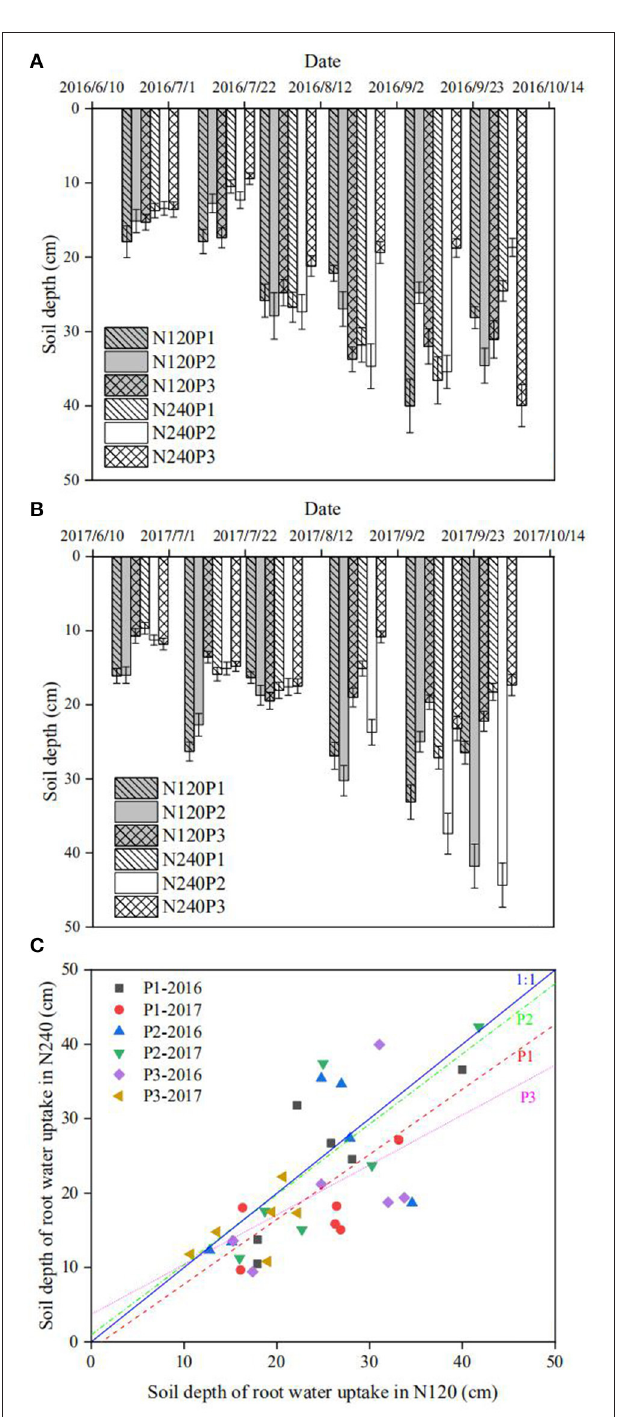
FIGURE 3 | Spatiotemporal changes in root uptake depth estimated from the intersection method in 2016 (A) , and 2017 (B) . The impact of different combinations of N fertilization and planting density on root water uptake depth estimated using the intersection method for all treatments over the 2-year experiment (C)